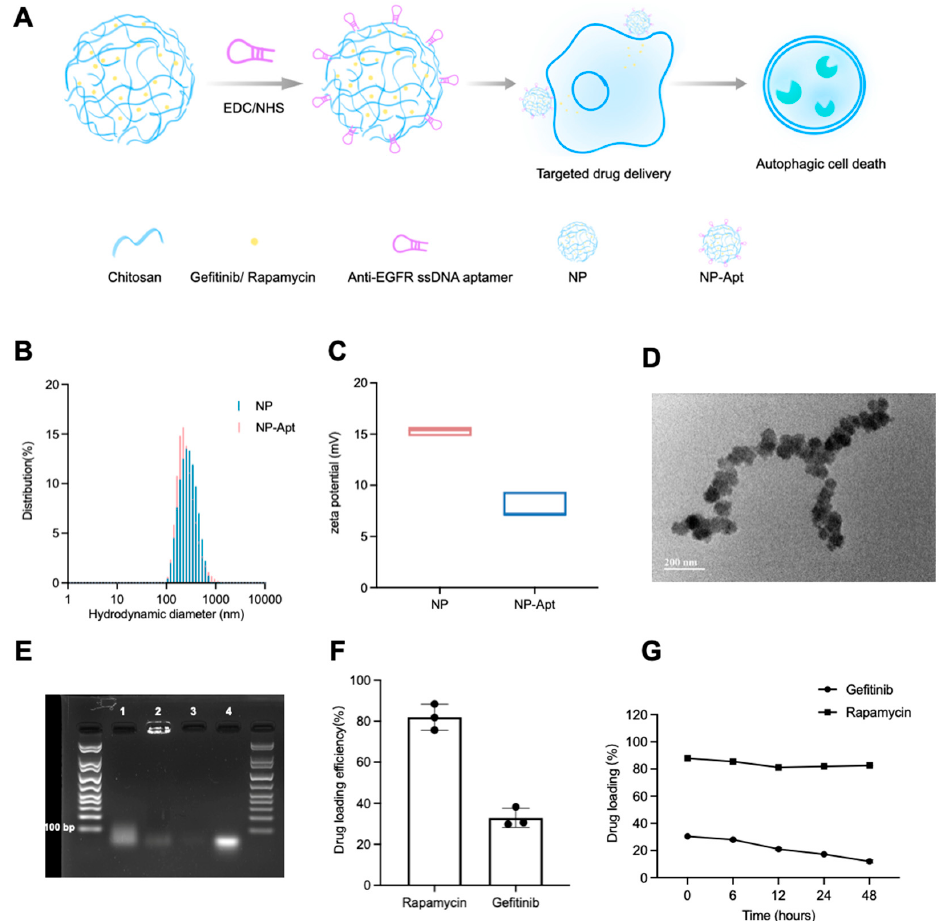
Figure 3. Construction and characterization of NP and NP-Apt. ( A ) Schematic illustration of gefitinib and rapamycin-loaded NP-Apt (NP-Apt [gefitinib + rapamycin]). ( B ) The hydrodynamic size distribution of NP and NP-Apt. ( C ) Zeta potential analysis of NP and NP-Apt. ( D ) TEM picture of NP-Apt. ( E ) Agarose gel electrophoresis. 1. The mixture of Apt and NP; 2. NP-Apt; 3. NP; 4. Free aptamer. ( F ) Drug loading efficiency of gefitinib and rapamycin. The maximum absorbance of gefitinib and rapamycin was 343 and 283 nm, respectively. ( G ) Stability of NP-Apt (gefitinib + rapamycin) at 37 ◦ C in